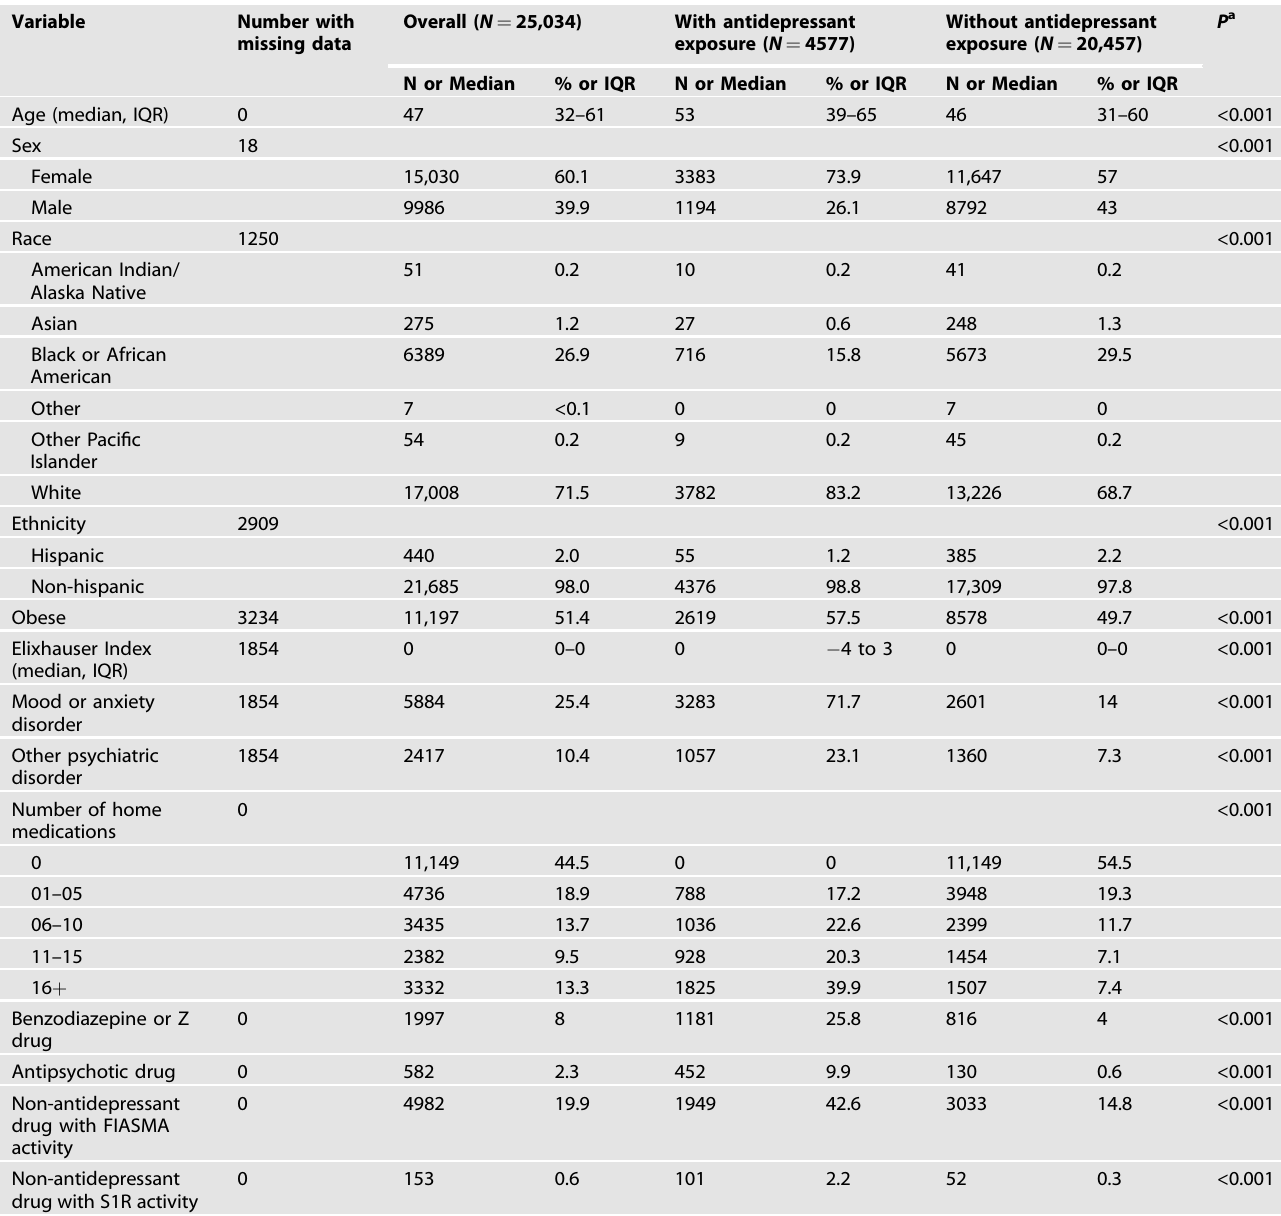
Table 1. Characteristics of patients with and without antidepressant